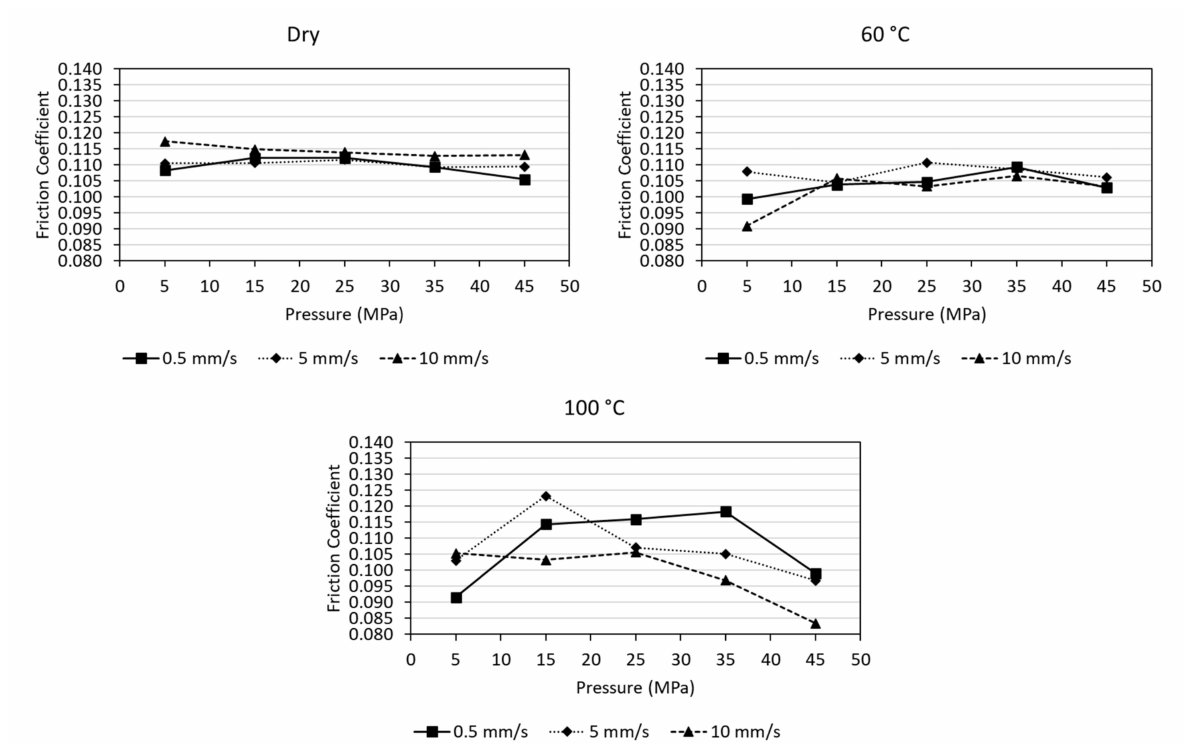
Figure 6. Dependence of average friction coefficients at the speeds of 0.5, 5 and 10 mm/s on pressure for the dry condition in room, 60 ◦ C and 100 ◦ C